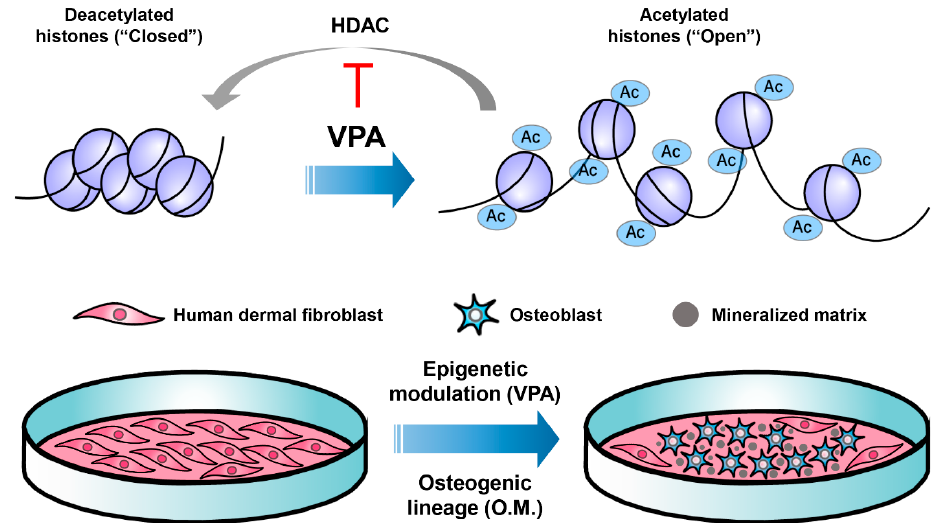
Figure5. Schematicillustrationofincreaseddirectconversionefficiencyofsomaticcellsintoosteoblastsand Figure 5. Schematic illustration of increased direct conversion efficiency of somatic cells into osteoblasts and mineralization by supplementation of VPA in osteogenic medium (O.M.). VPA mineralization by supplementation of VPA in osteogenic medium (O.M.). VPA promotes chromosomal remodeling and maintains acetylated histones as an “open form” of the chromatin structure by acting as an inhibitor of